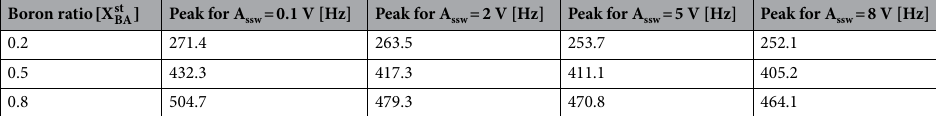
Table 2. Average absorption frequency peaks evaluated for nNAMeG samples at different voltage levels (σ α peak < ±